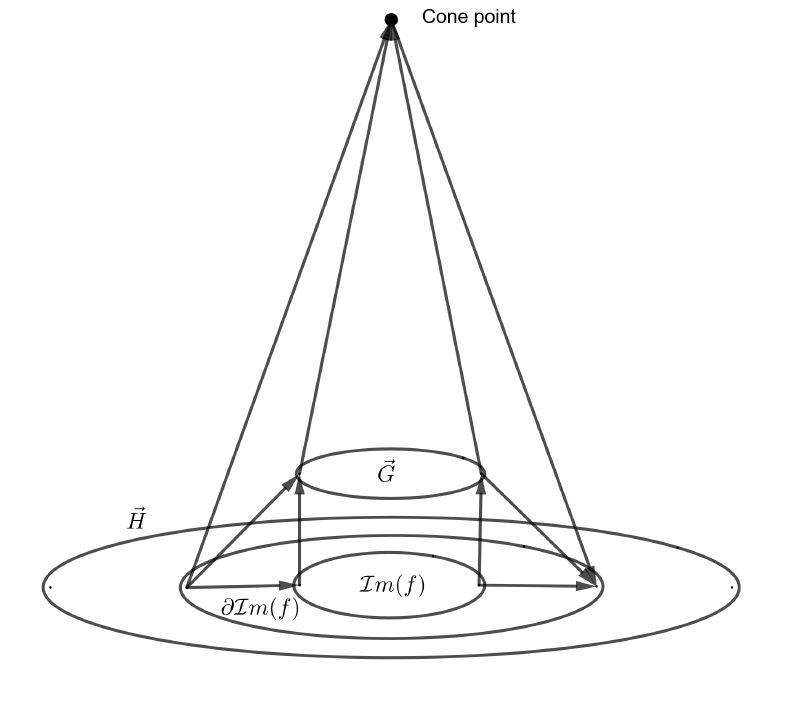
Figure 1. Digraph cofiber of a digraph map f : (cid:126) G → (cid:126) H